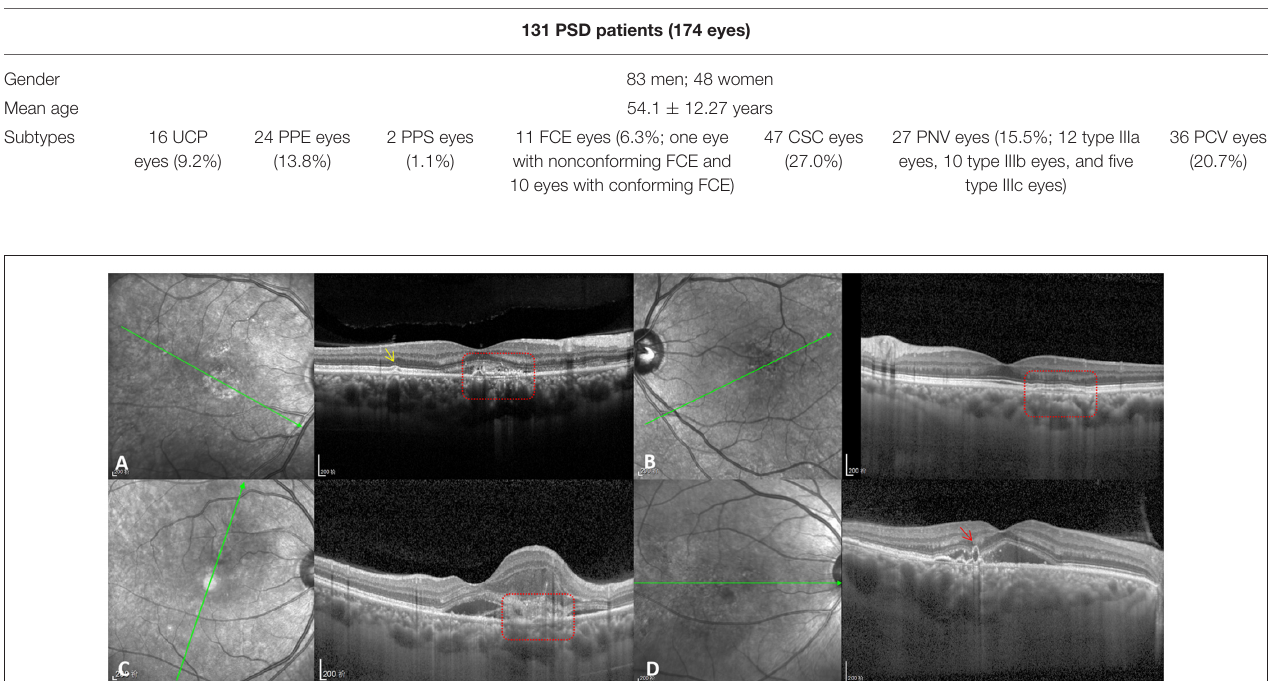
greater in PSD eyes without CNV than in neovascular PSD